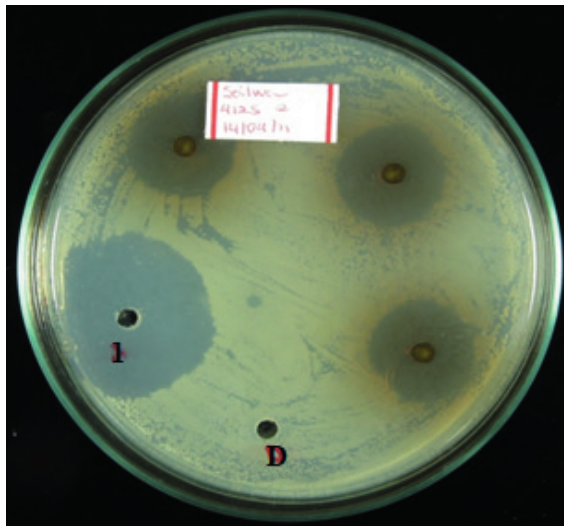
Figure 1 - Inhibition zones of sage ( S. officinalis ) extract on S. aureus 4125. the positive control of growth inhibition antibiotic ampicillin was identified in the figure by number 1. the negative control of inhibition was done with DMSO